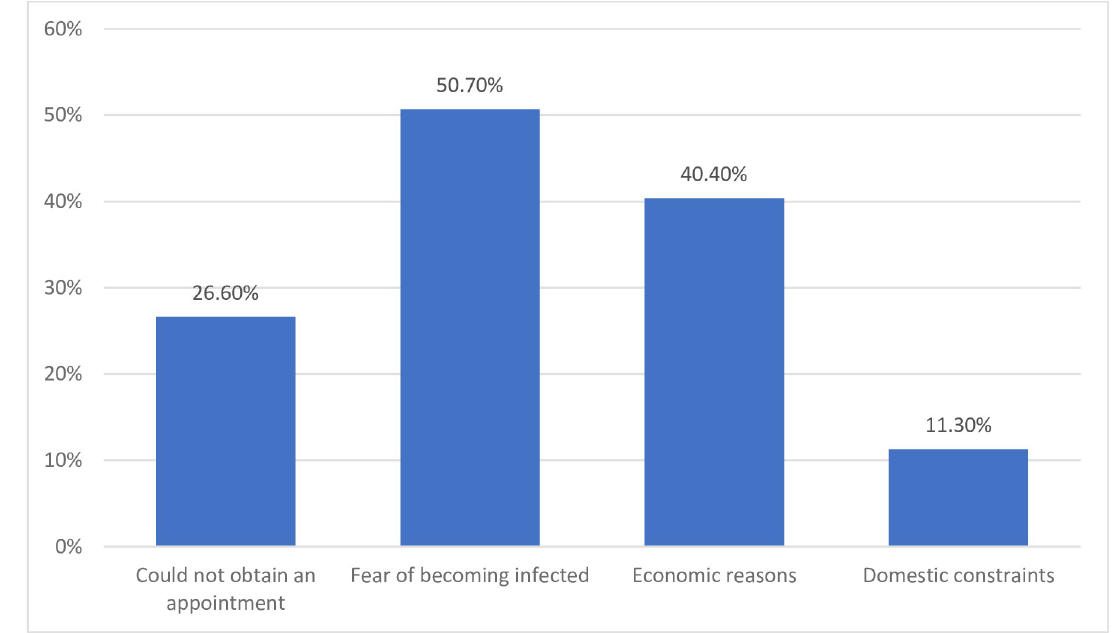
Fig 1. Reasons for lack of psychological support (COCONEL 2020, May 7–10, N = 245). Note: The items were not exclusive (a respondent could choose several reasons). Population: respondents for the COCONEL survey May 7–10 wave who perceived a need for psychological support from a health professional (N =